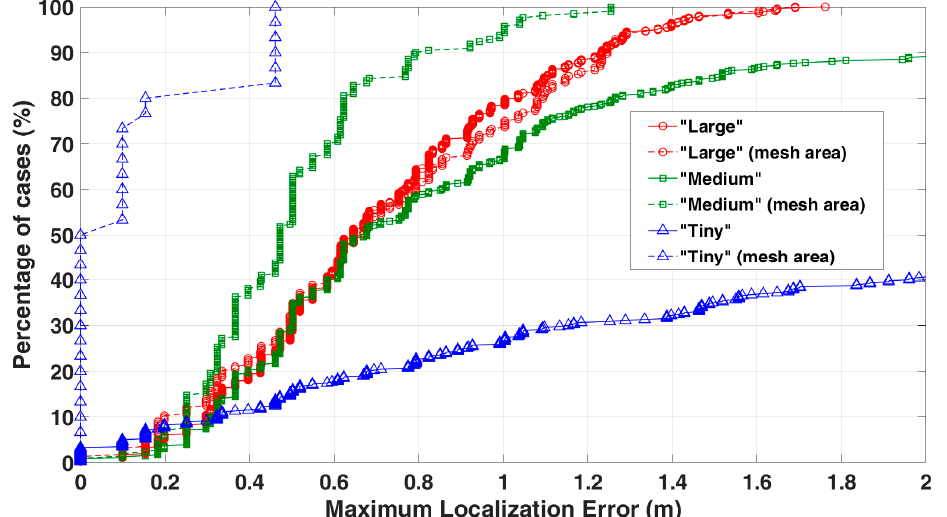
Figure 11. Simulated localization error CDFs, with the three anchor networks. Data acquired at the 299 points in the room of Figure 9a, assuming the mobile tag pointing upward, 5 averaged RSSI data for point and each antenna element, mobile tag height = 1.1 m.